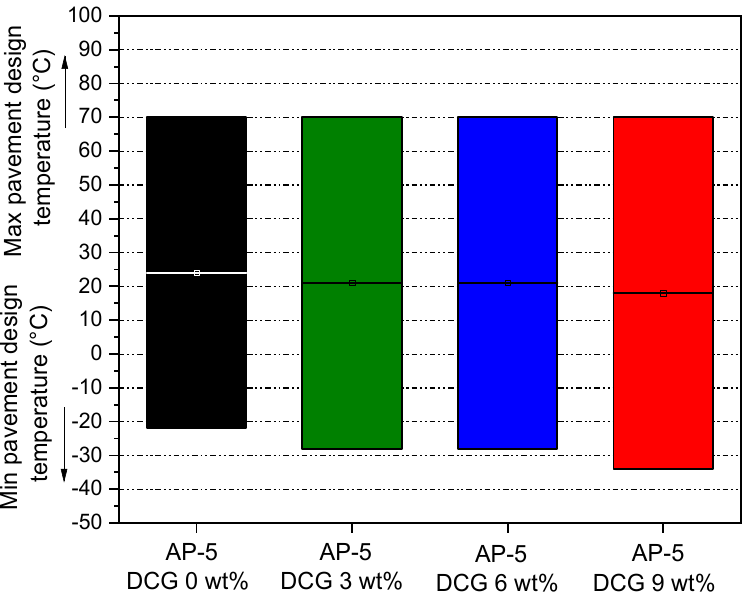
base AP-5 Figure 15. Impact of various amounts of DCG (e.g., 3, 6, 9 wt%) on the performance grade (PG) of base AP-5 asphalt.